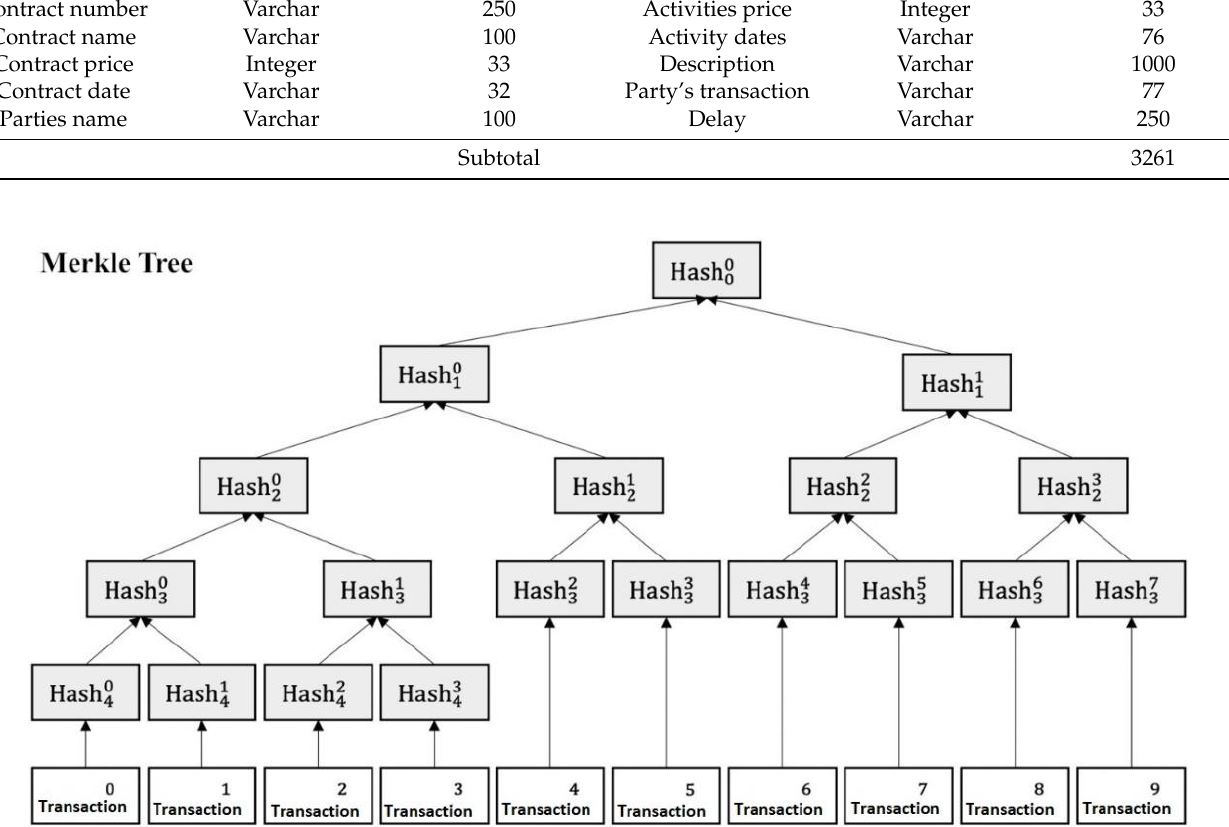
Figure 11. The structure of the Merkle tree. Table 6. Storage size calculation in the block.